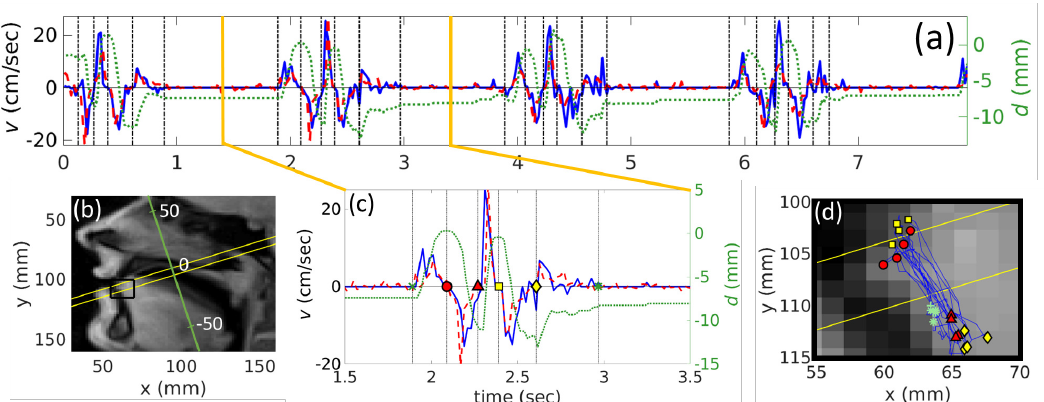
Figure 4. Results for S1 articulating /tata/ calculated from real-time MRI. ( a ) the whole velocity v (time) (the left scale) and the displacement d (time) curves (the right scale). The solid curve denotes velocity found manually, the dashed curve corresponds to automatically evaluated velocities, and the dotted line corresponds to the tongue tip displacement. The solid bold vertical lines present the borders of the Figure 4c. Positive velocity values correspond to the upward tongue tip movement to achieve the constriction; ( b ) part of an image taken in the mid-sagittal plane, with the region of interest, shown in Figure 4c (solid black rectangle) and the displacement axis (the inclined axis); ( c ) example of one repetition of /tata/. Vertical dash-dotted black lines indicate points t 0 − t 5 where velocity becomes zero and are denoted as the x ( t 0 ), the circle ( t 1 ), the triangle ( t 2 ), the square ( t 3 ), the diamond ( t 4 ) and the asteriks ( t 5 ); ( d ) the whole trajectory of the tongue motion on an image in the mid-sagittal plane with the same markers as for Figure 4c corresponding to t 0 − t 5